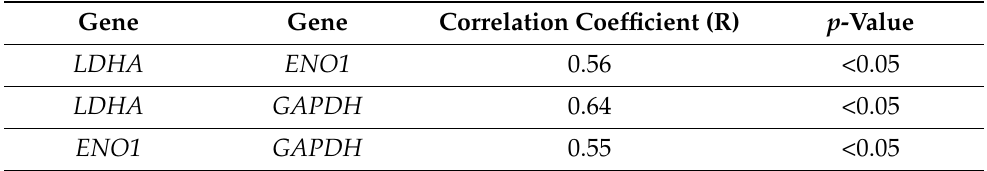
Figure 9. Overall survival analysis of glycolysis-related genes. ( a ) OS Kaplan–Meier analysis was performed using the GEPIA2 online application. The solid and dotted lines represent the survival curve and 95% confidence interval, respectively. ( b ) Differential expression boxplot of genes ( LDHA, GAPDH, and ENO1 ) in GBM in The Cancer Genome Atlas (TCGA) database obtained from GEPIA2 [35]. Table 1. Pearson correlation analysis of glycolysis-related genes in GBM.